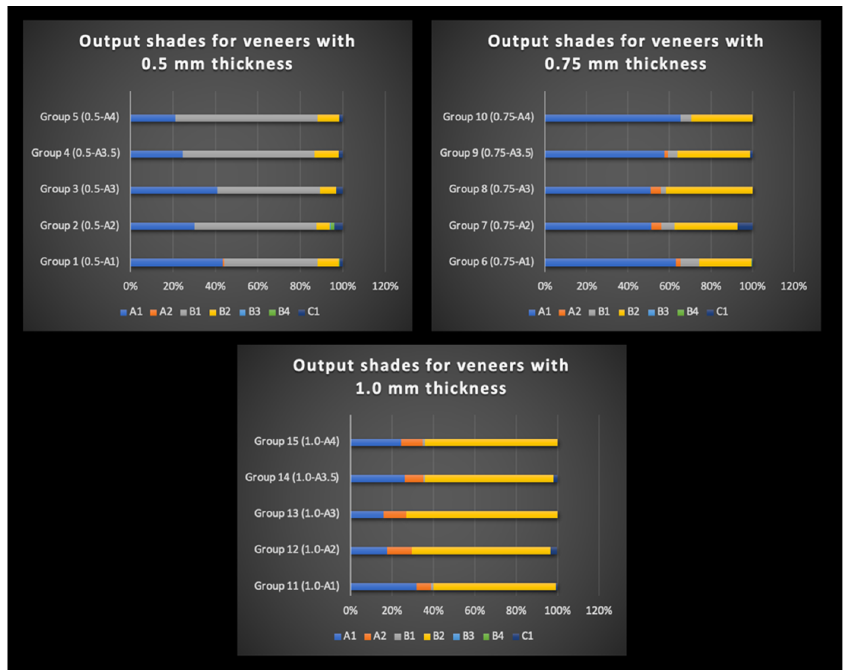
Figure 1. Output shade percentage distribution for zirconia veneers with 0.5 mm ( top left ), 0.75 mm ( top right ), and 1.0 mm ( bottom center ) thickness over backgrounds with shade A, A2, A3, A3.5, and A4.